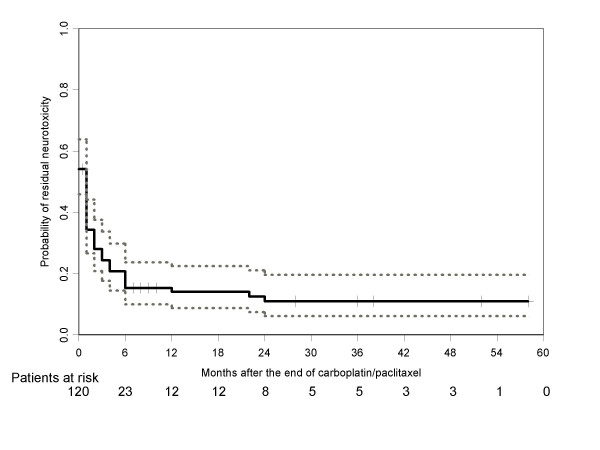
Kaplan-Meyer curve of time to resolution of neurological toxicity in patients with epithelial ovarian carcinoma treated with the combination of carboplatin and paclitaxel (dotted lines represent 95% confidence interval).